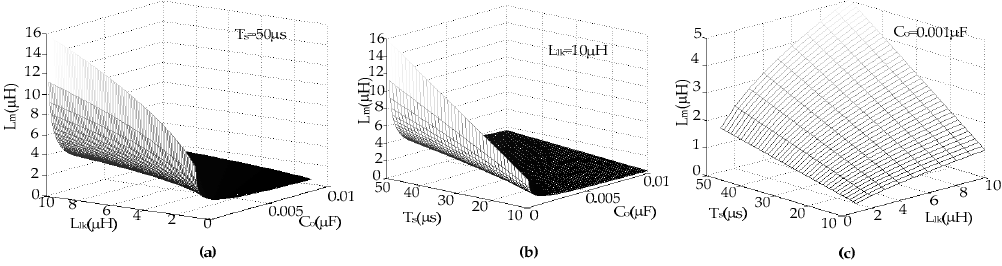
Figure 8. Required L m to obtain ZVS versus C o , L lk and T s : ( a ) T s = 50 µ s; ( b ) L lk = 10 µ H; ( c ) C o = 0.001 µ F.